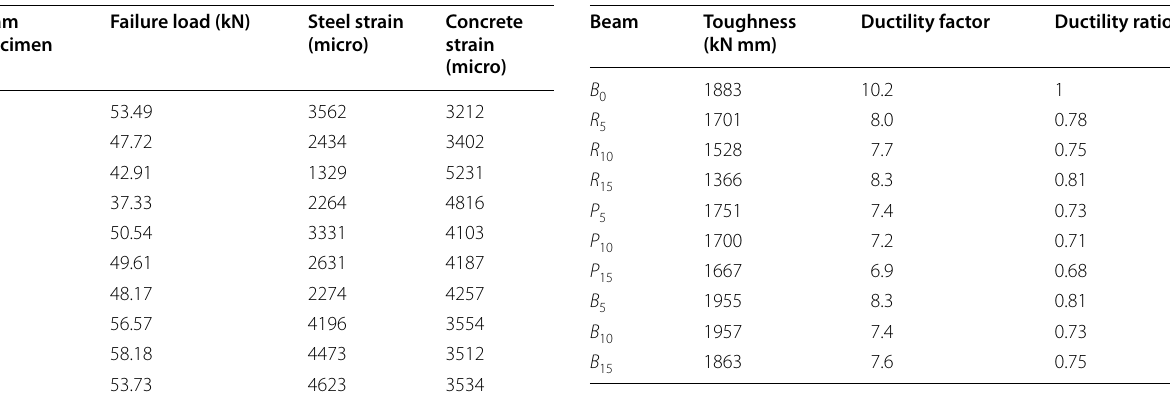
Table 2 Measured concrete and steel strain at failure. Table 3 Toughness and ductility factors of the